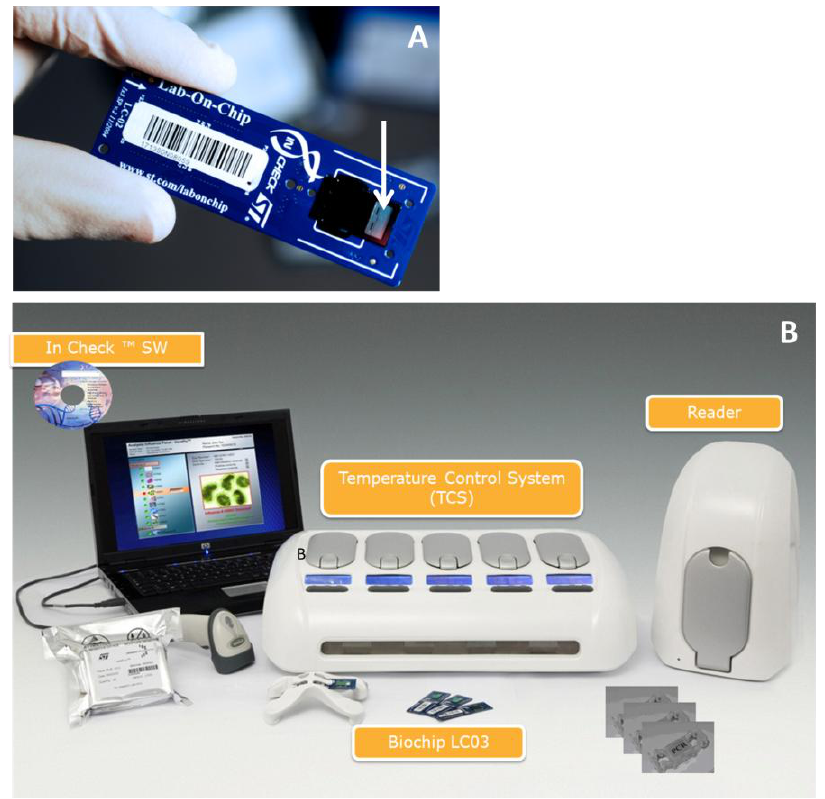
Figure 1. The main components of In-Check platform: ( A ) The Lab-on-Chip core device amplifies clinically relevant DNA samples by Polymerase Chain Reaction (PCR) and has an integrated custom low-density microarray (showed by the white arrow). ( B ) In-Check platform instruments. The Lab-on-Chip interfaces to the Temperature Control System (TCS) that actuates, monitors, and controls the parameters of the reaction. The TCS unit comprises five control modules with independent thermal protocols and random access capability. Optical signal acquisition is performed on a dedicated portable reader and processed by ST's specialized bioinformatics software. The software package allows users to easily monitor and control reaction processes, analyse the results and automatically generate diagnostic